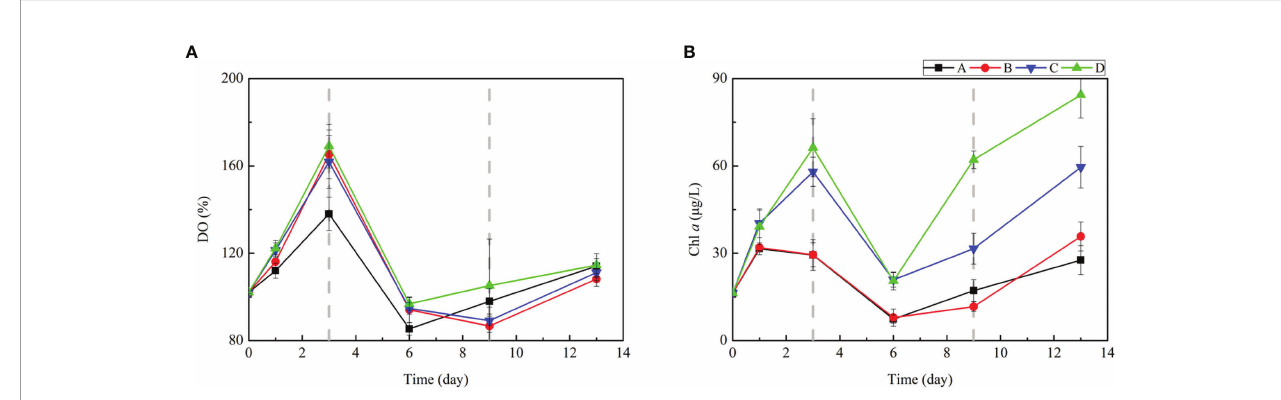
FIGURE 1 | Changes in (A) DO, (B) Chl a during the incubation experiment. The error bars represent the standard deviation from triplicate